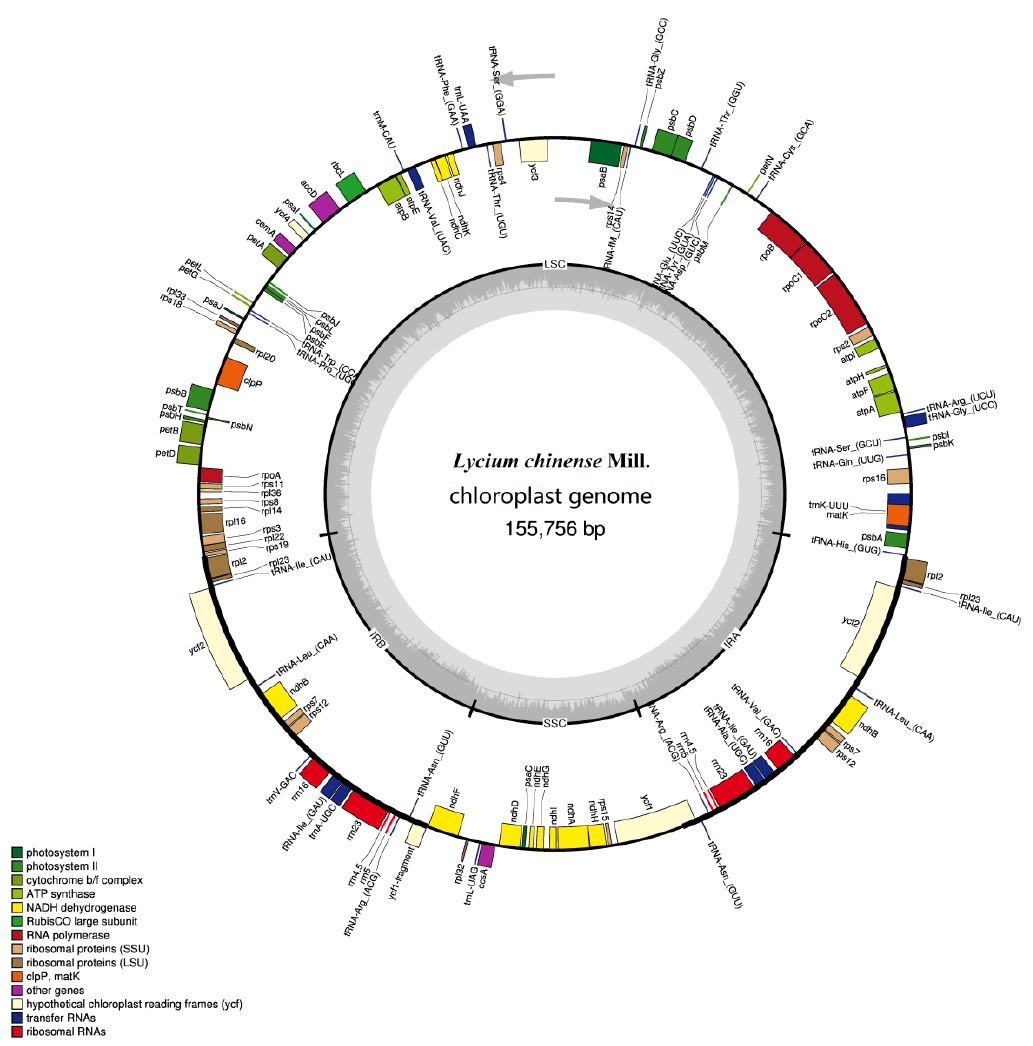
Figure 1. Gene map of the L. chinense chloroplast (CP) genome. Genes inside the circle are transcribed clockwise, and counterclockwise transcribed otherwise. Filled colors represent different functional groups according to the legend on the left bottom. The gray arrow represents gene direction. The darker gray in the inner circle corresponds to GC content, whereas the lighter gray corresponds to AT content. Table 1. Base composition in the chloroplast genome of L. chinense.